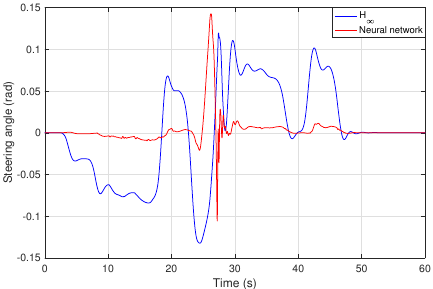
Figure 17. Control input of the